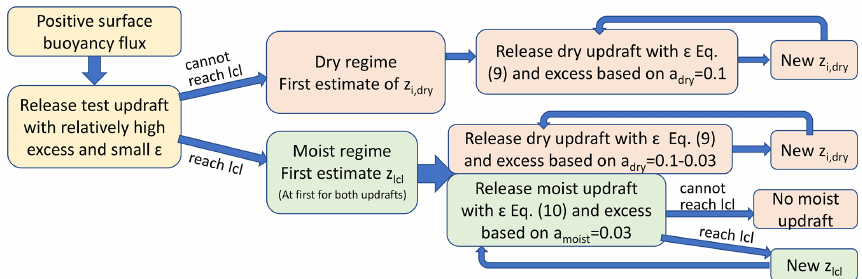
Figure 3. Schematic diagram of the subsequent steps in the shallow convection scheme to determine the ultimate inversion heights and cor- responding entrainment formulations and the diagnosed regimes. After the test parcel (yellow), two iteration steps are done per entrainment formulation (red refers to dry and green to moist). Although the test parcel might have diagnosed a cloudy regime, it is possible that the ultimate moist updraft could not reach the lcl. In this case, no moist updraft is active (left panel of Fig.